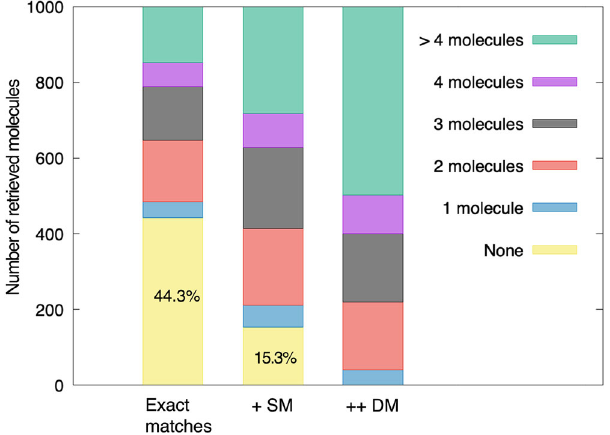
Fig. 6 Retrieval of reactant candidates via a large PubChem compound search database. SM and DM represent single mutation and double